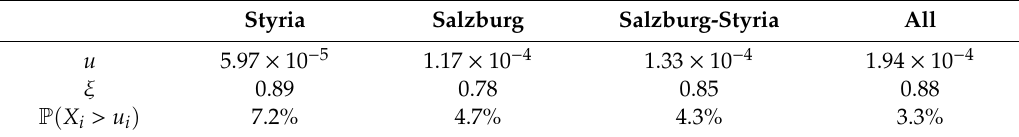
Table A5. Estimation results for the threshold, the extreme value index and the probability of a large